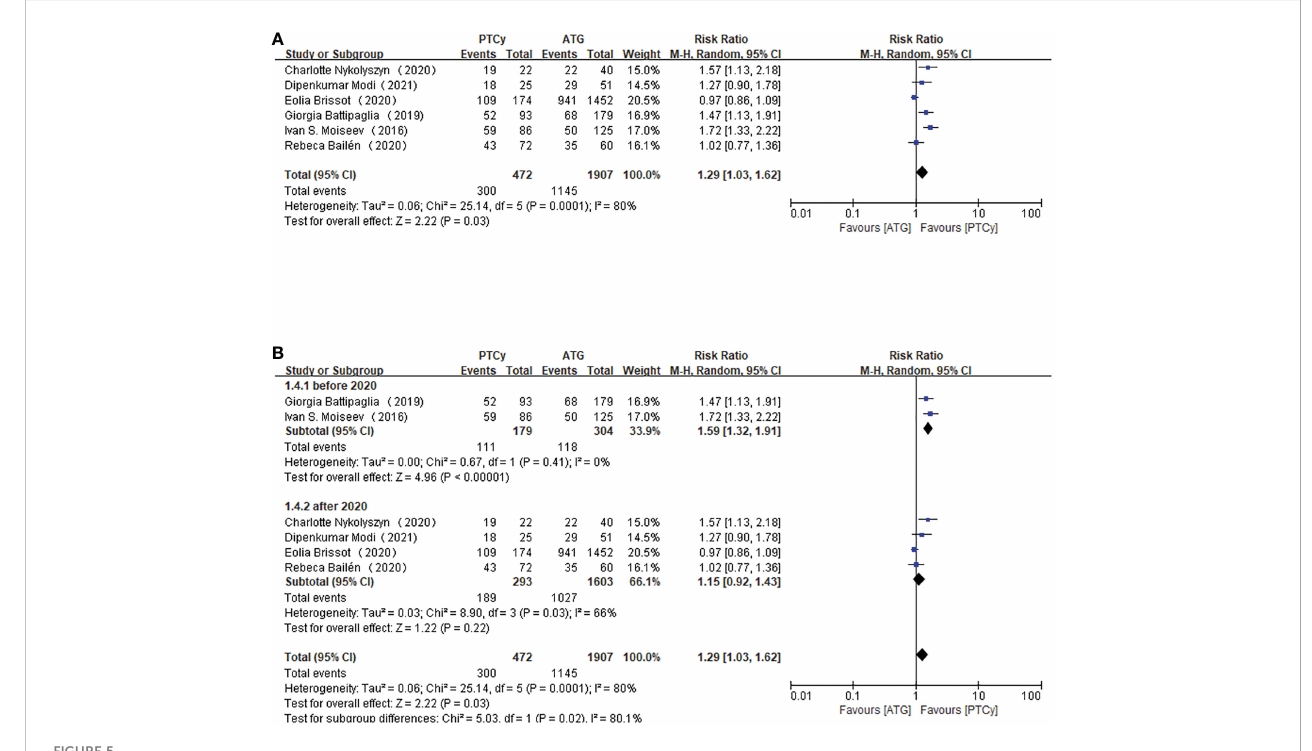
FIGURE 5 Forest plot of OS (A) and subgroup analysis of OS according to the published year (B)